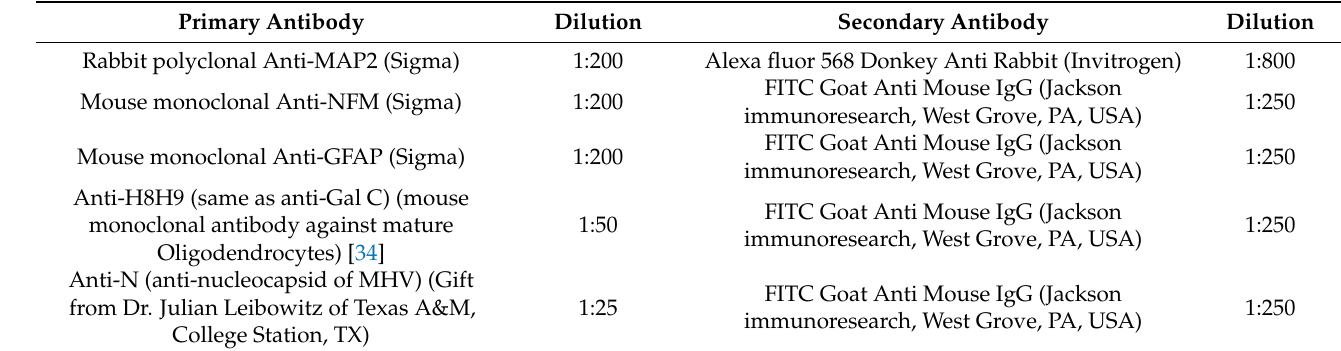
Table 1. Antibodies and respective dilutions used for